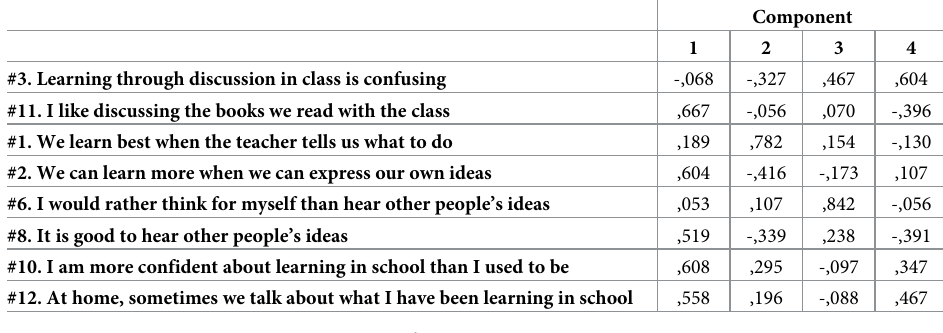
Table 8. Component matrix for DLGs a,b .